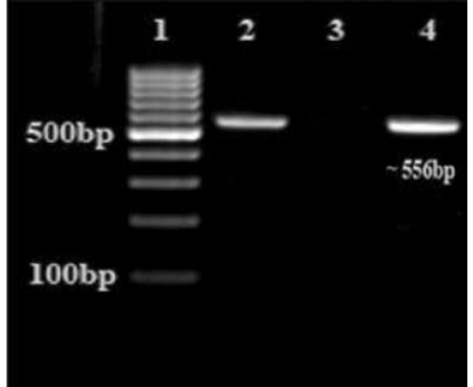
Fig.2. Agarose gel electrophoresis of RT-PCR amplified product of AccI-SpeI region of VP2 gene from bursal tissue, 556 bp Lane 1: 100 bp DNA marker, Lane 2: Positive control, Lane 3: Negative control Lane 4: bursal tissue sample